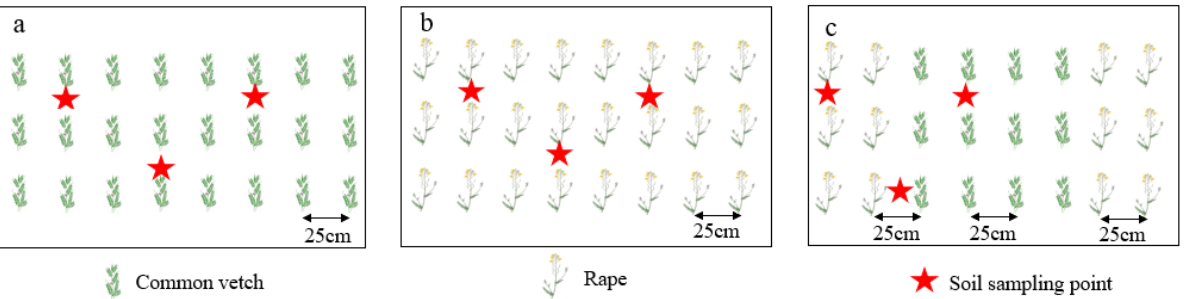
Figure 2. Schematic diagram of monoculture common vetch ( a ) monoculture rape ( b ) intercropping of rape and common vetch ( c ) and the location of soil sampling in different treatments.